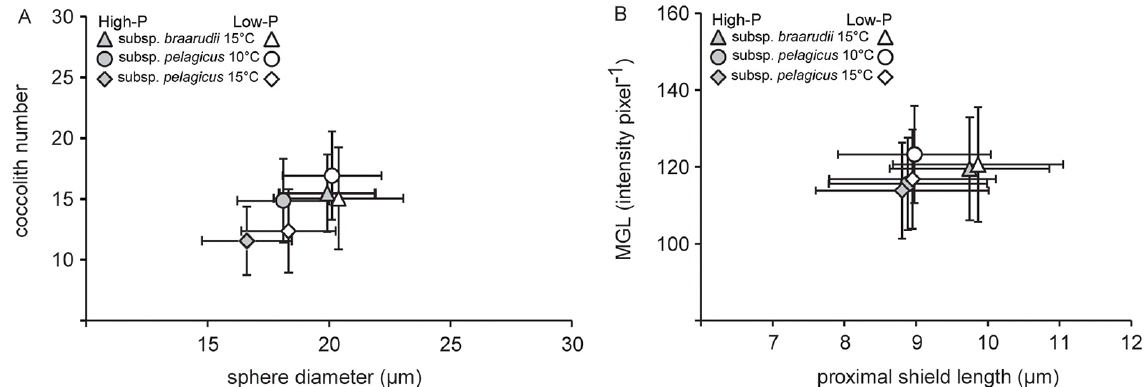
Figure 4. (A) Number of coccoliths per coccosphere plotted against the diameter of that coccosphere produced in high-P and low-P medium by Coccolithus pelagicus subsp. braarudii grown at 15 ◦ C and subsp. pelagicus grown at 10 and 15 ◦ C. (B) Mean grey level (MGL) plotted against mean proximal shield length (PSL) of individual coccoliths. Mean ± SD. Values for subsp. braarudii at 15 ◦ C and subsp. pelagicus at 10 ◦ C are combined for the main and additional